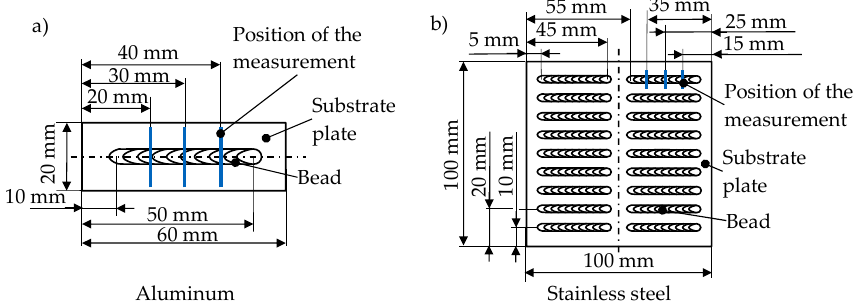
Figure 3. Schematic visualization of the specimens for the experiments with ( a ) aluminum and ( b ) stainless